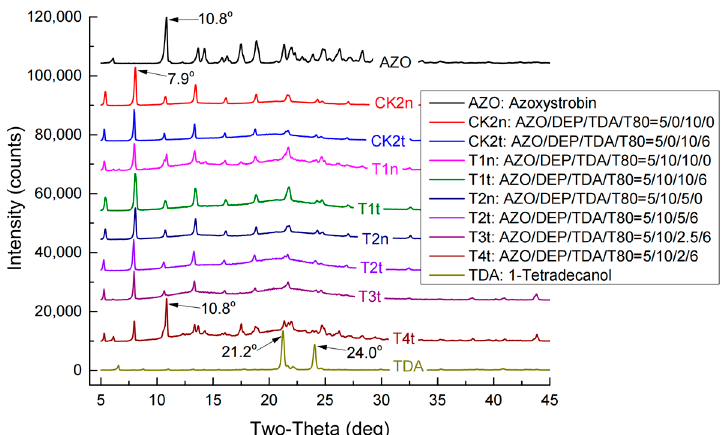
Figure 2. XRD patterns of oil-phase samples.